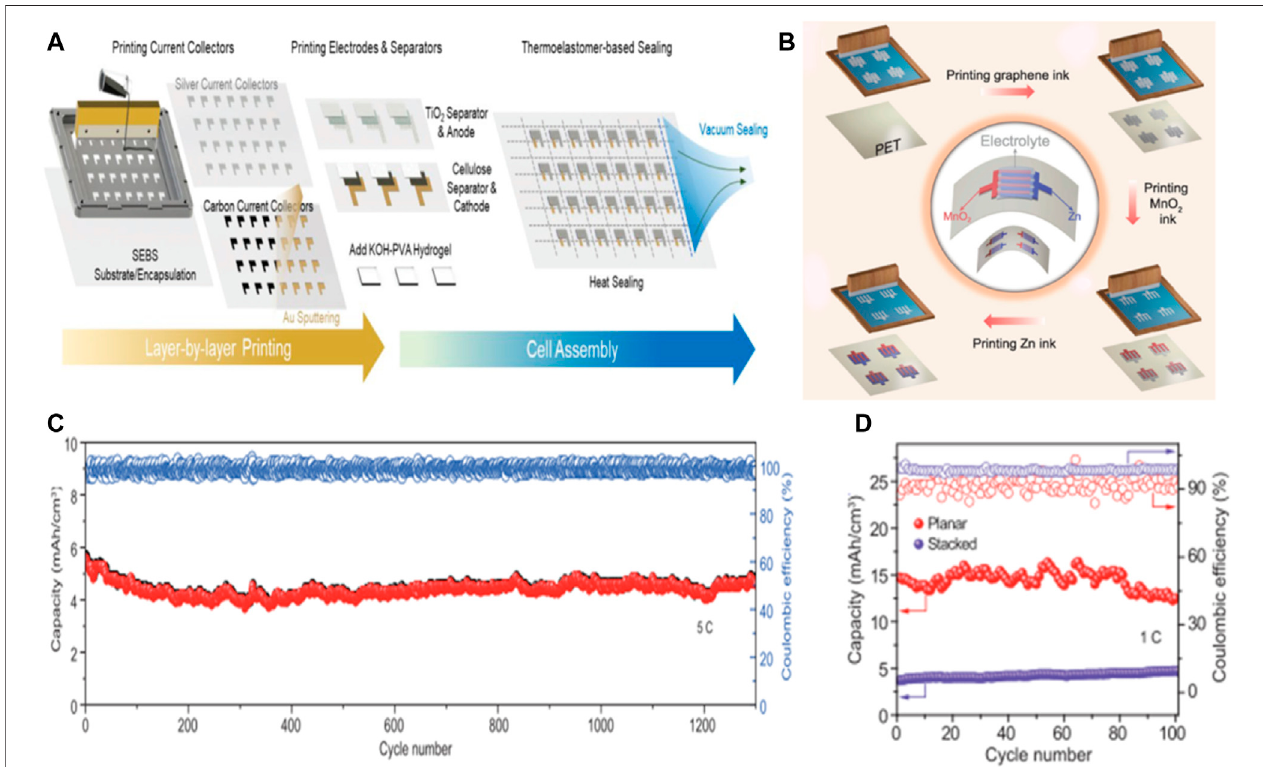
FIGURE 9 | (A) The process of assembling the fl exible, rechargeable, and high-capacity AGO-Zn battery is silkscreen printed layer by layer and vacuum sealed. Copyright 2019 ResearchGate. (B) Zn//MnO 2 planar MBs was prepared by printing. Schematic diagram of printing zinc//MNO 2 MB by screen printing method: Blank PETsubstrate, printing graphene collector electrode, printing MnO 2 cathode and Zn anode. Electrochemical performance of printed Zn//MnO 2 planar MBs (C) cycling stabilities of printed Zn//MnO 2 MBs with planar and sandwich-like stacked geometries, measured at a rate of 1 C; (D) long-term cycle stability of Zn//MnO 2